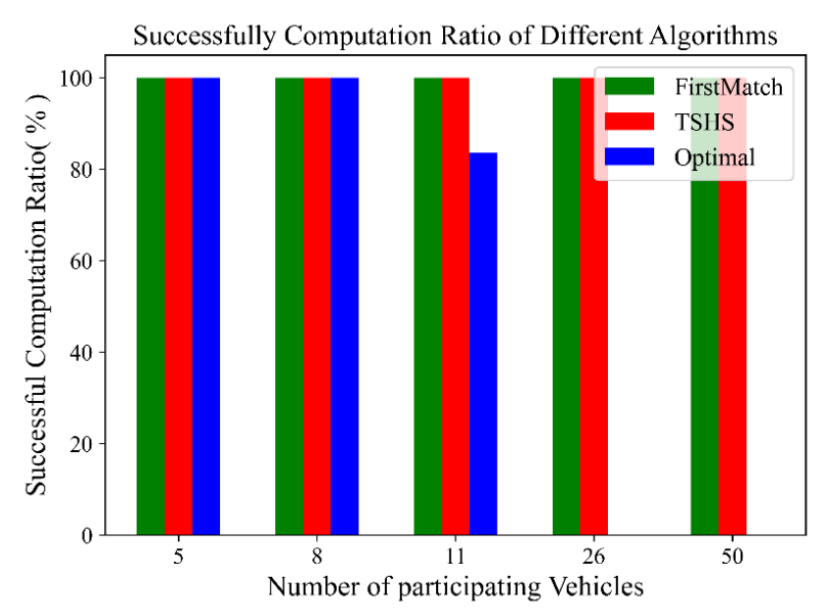
Figure 6. Successful computation ratio of different algorithms under diverse cluster scales.